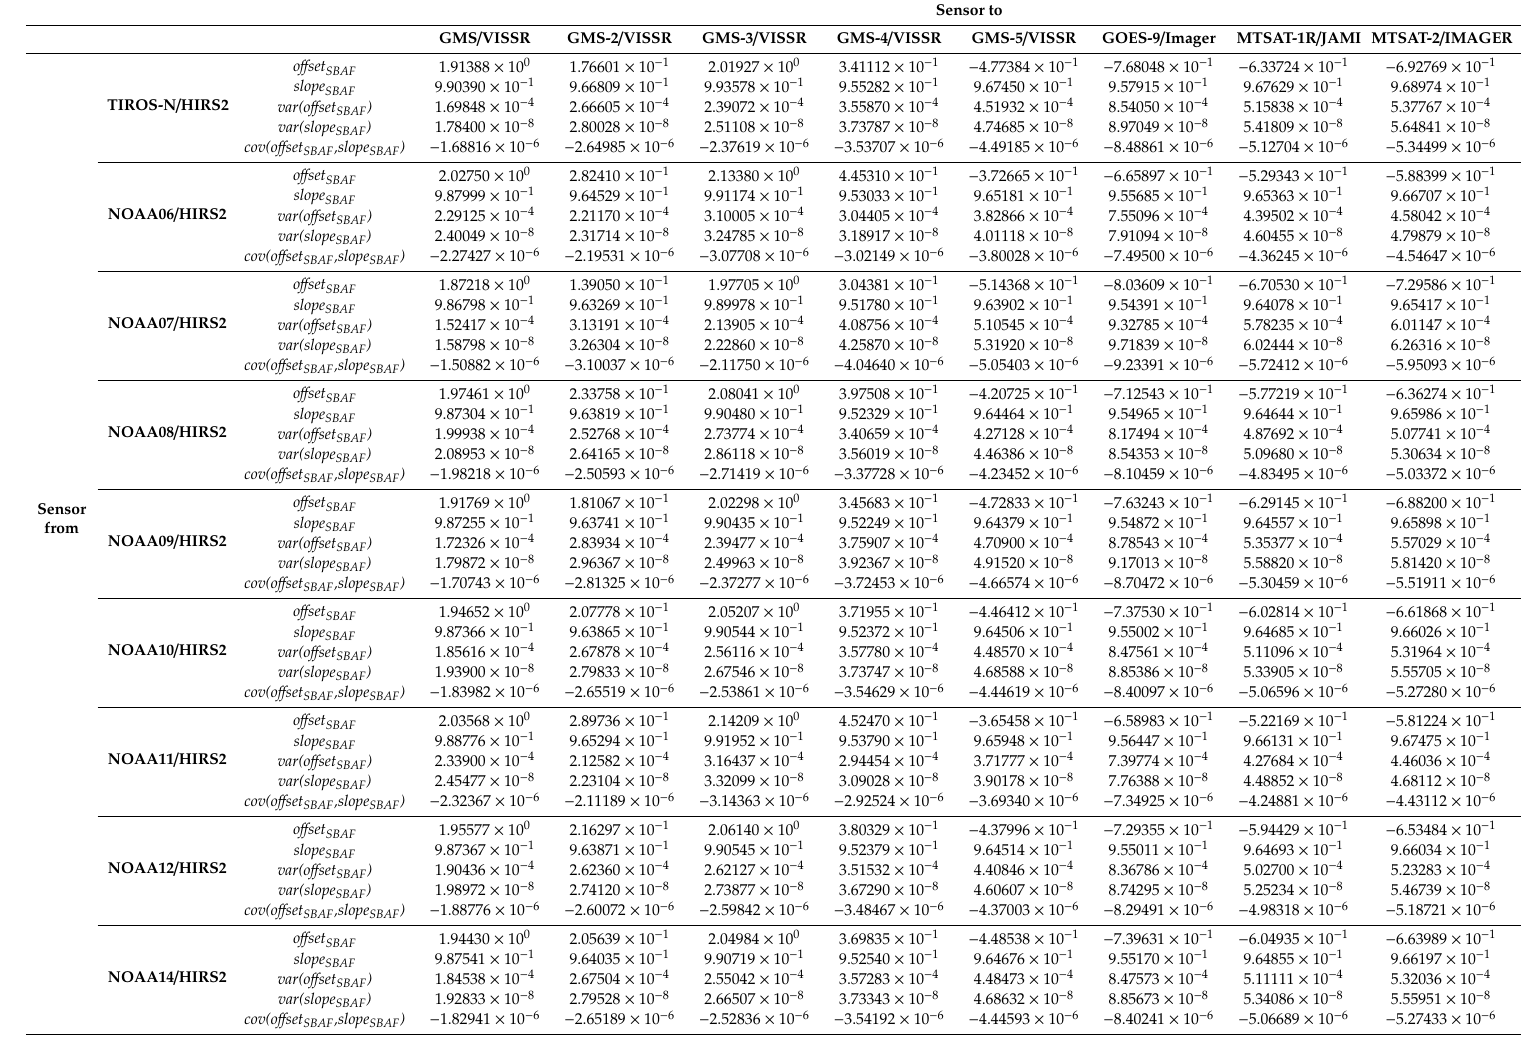
Table A1. SBAFs for the IR channel radiances from channel 8 on HIRS2 to those of the IR channel on the historical JMA’s satellites (unit: mW / (m 2 sr cm − 1